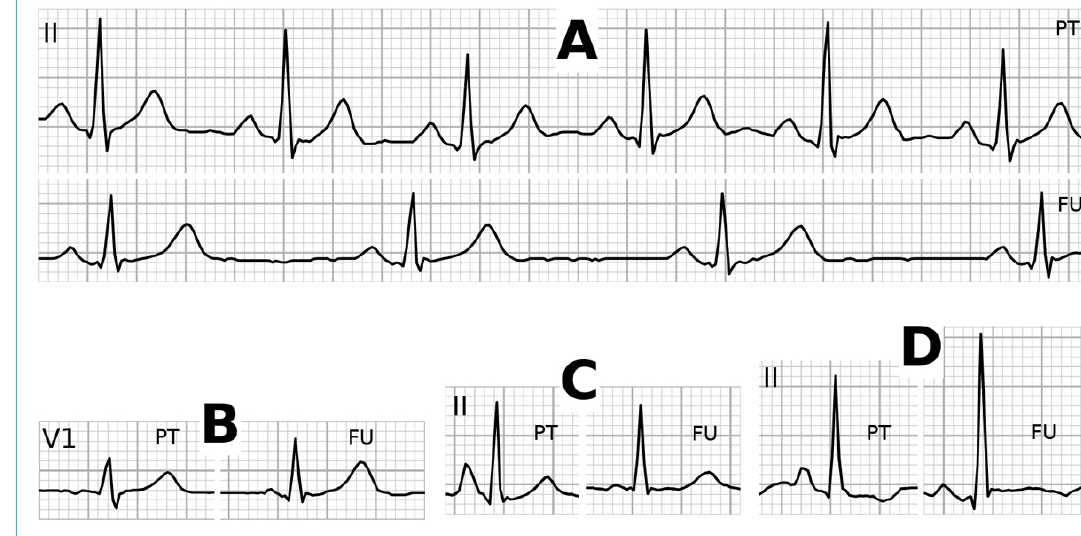
Not available 1.0